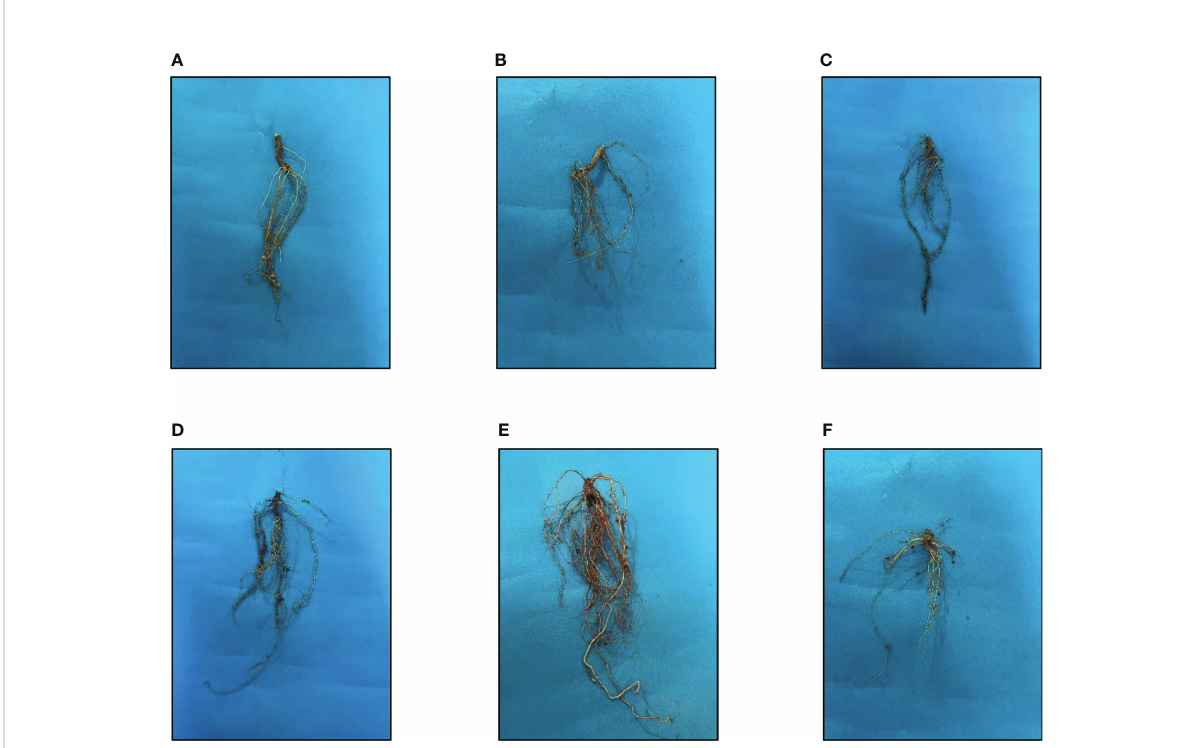
FIGURE 9 Effects of different GO NPs treatments on root lengths of mungbean. (A) = C= without GO NPs application (control); (B) = T1= 300 mg/L; (C) = T2= 600 mg/L; (D) = T3= 900 mg/L= (E) = T4= 1200 mg/L; (F) = T5= 1500